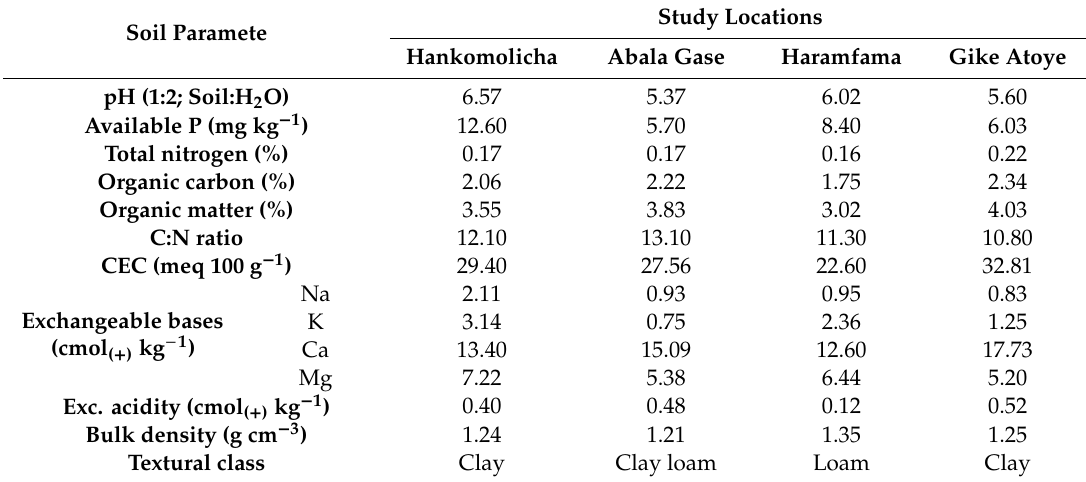
Table 2. Physico-chemical properties of surface soils (0–20 cm) at the study locations. Soil